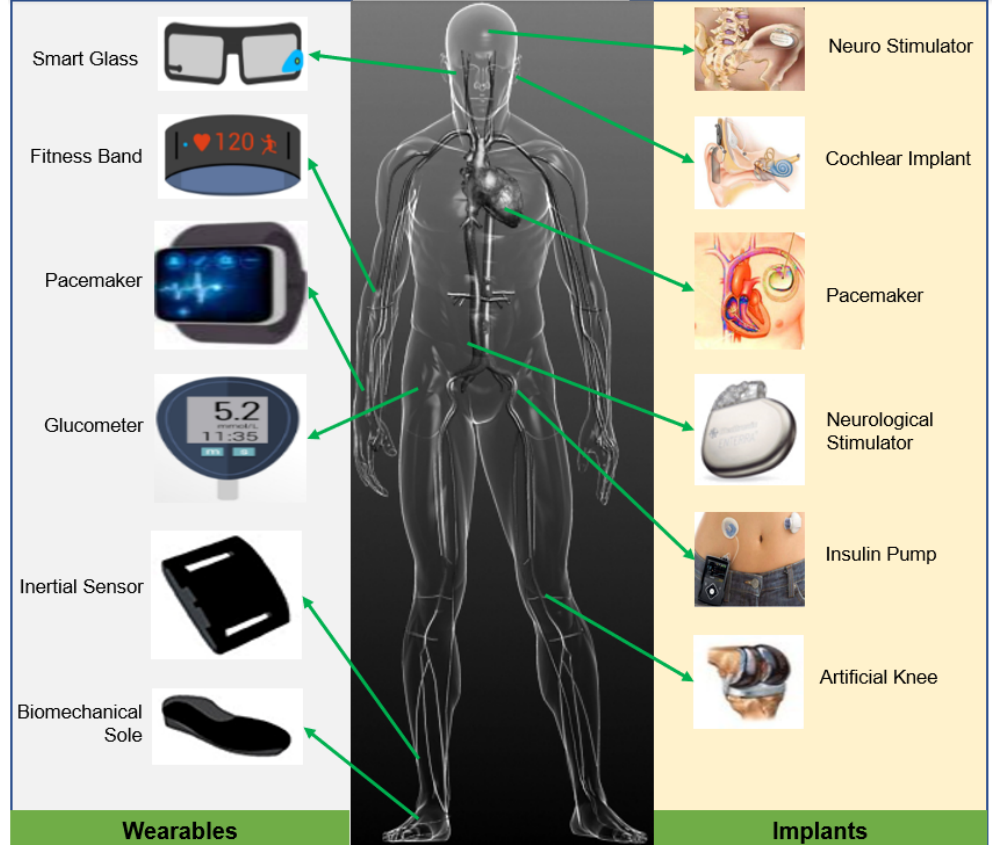
Figure 1. Different wearable and implantable medical devices typically used in precision